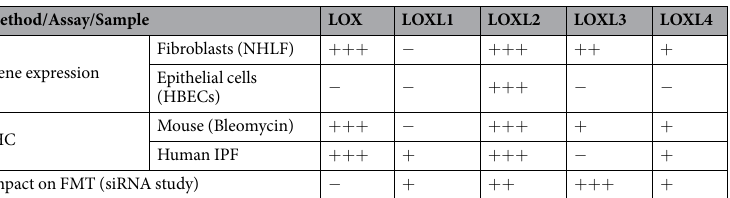
As a first step we analyzed basal gene expression levels of LOX/L family members in primary lung fibroblasts (NHLFs) and differentiated bronchial epithelial cells (HBECs). Under physiological conditions we detected basal expression of all LOX/L family members at varying levels in both cell types analyzed, with LOXL3 being the lowest expressed gene. Overall, LOX/L basal expression levels were more pronounced in fibroblasts than in epi- thelial cells. Stimulation of NHLF cells with pro-fibrotic growth factors (FGF, PDGF and TGF- β ) resulted in a broad response with elevated expression levels for all LOX/L family members, where LOXL4 showed the most pronounced upregulation by TGF- β among all LOX/L genes. These findings are in line with earlier studies, which showed that LOXL4 is a direct target of TGF- β signaling in aortic endothelial cells 25 . Interestingly, a more specific